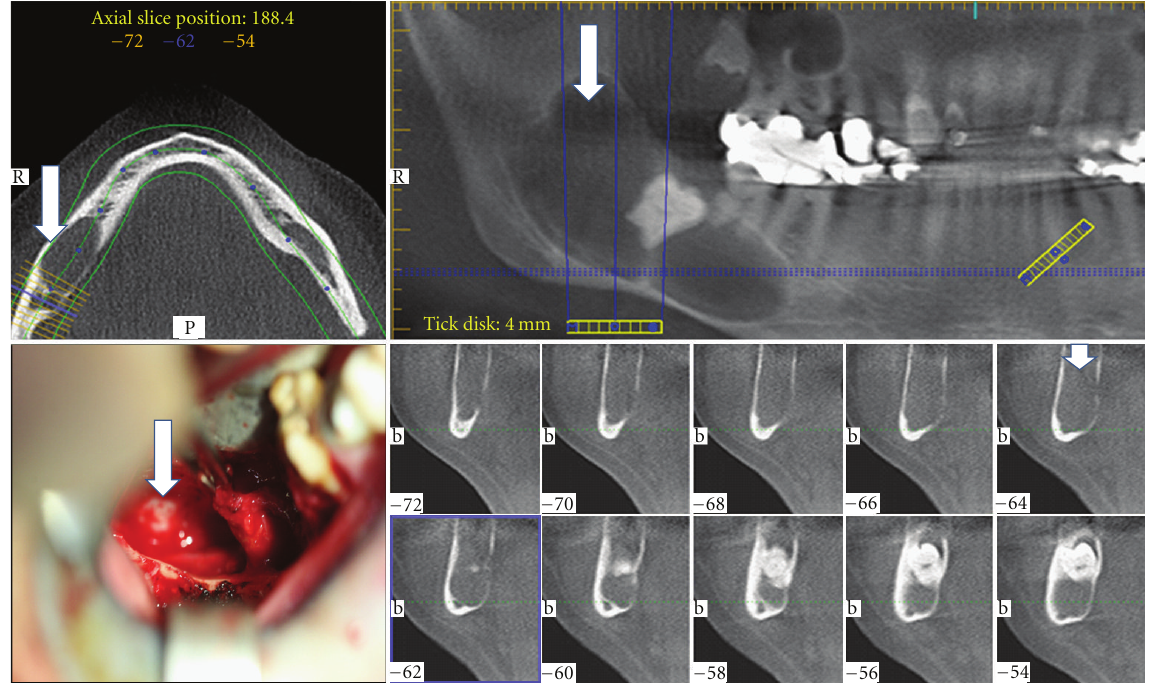
Figure 2: Mandibular defect following cyst. CT scan of huge cyst in the mandible (see white arrows). The clinical picture represents the situation after removing the cyst revealing the alveolar nerve positioned at the bottom of the cavity (black